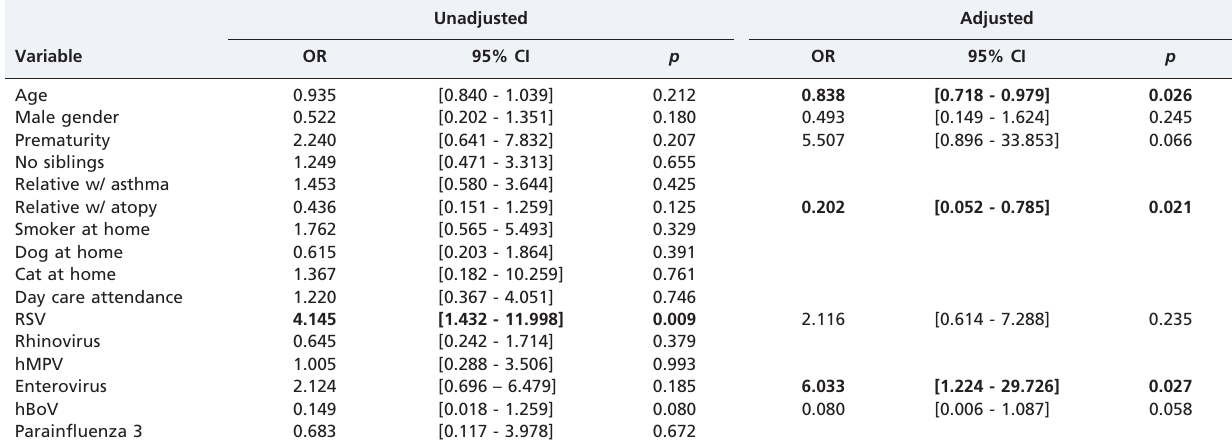
Table 3 - Logistic regression model results for hospital admission of infants with bronchiolitis (n= 77).